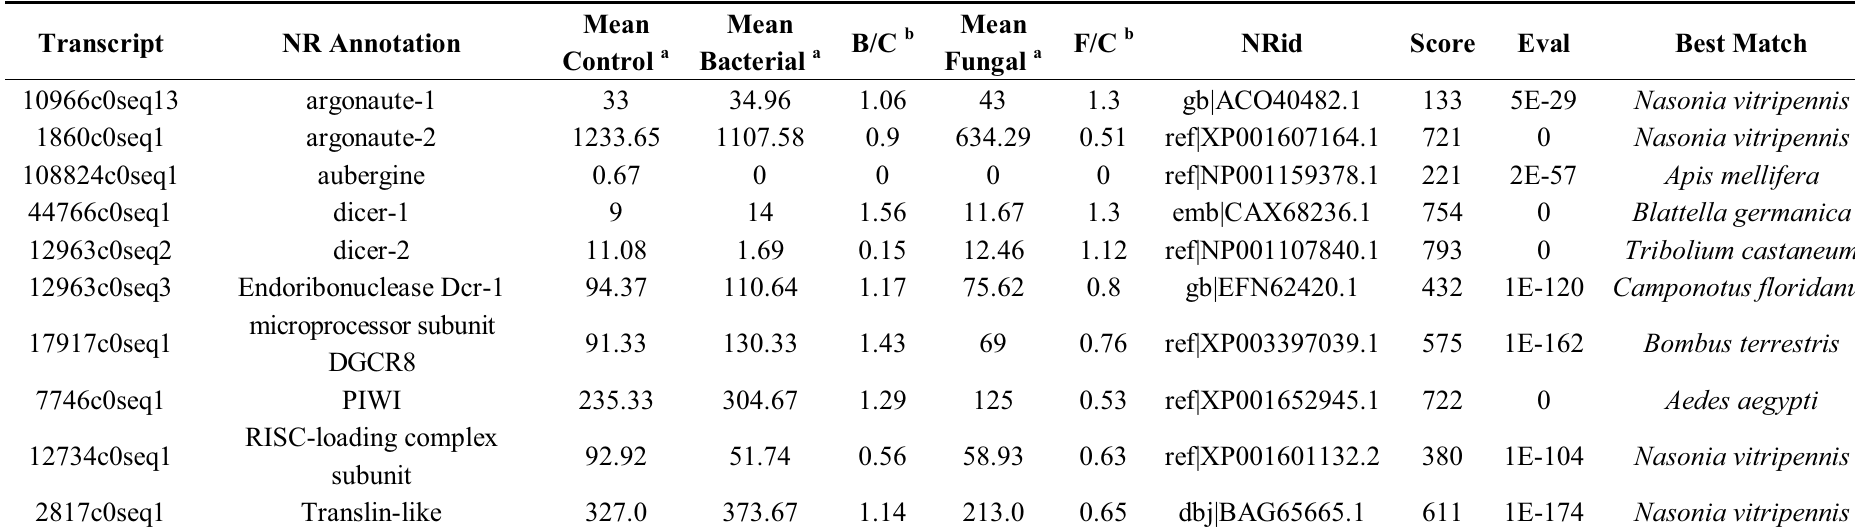
Table 4. Expression profiling of Anasa tristis RNA interference pathway genes in response to bacterial or fungal elicitation 18 h post